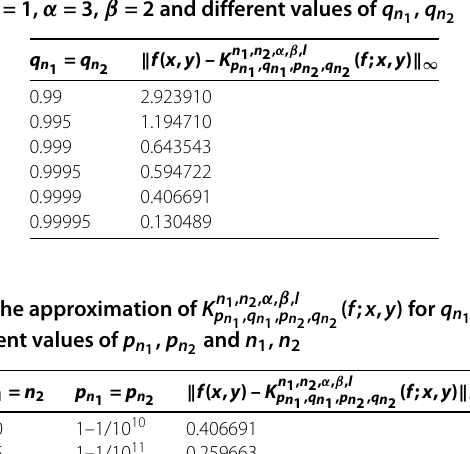
( f ; x , y ) for n 1 = n 2 = 10, n 1 , q n 1 , p n 2 , q n 2 , q n 1 2